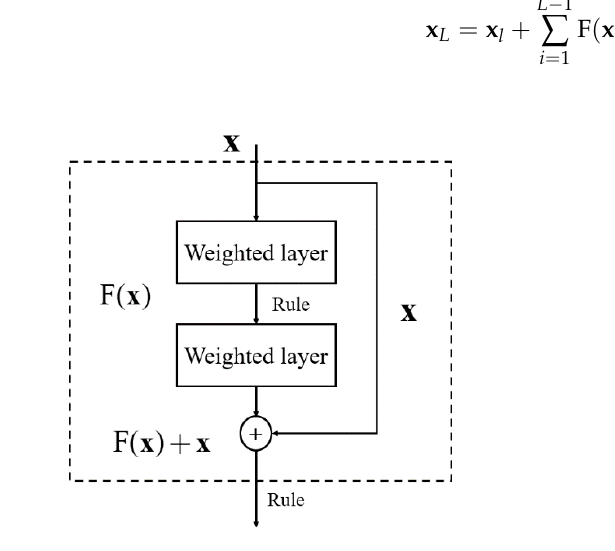
Figure 4. A residual learning unit.